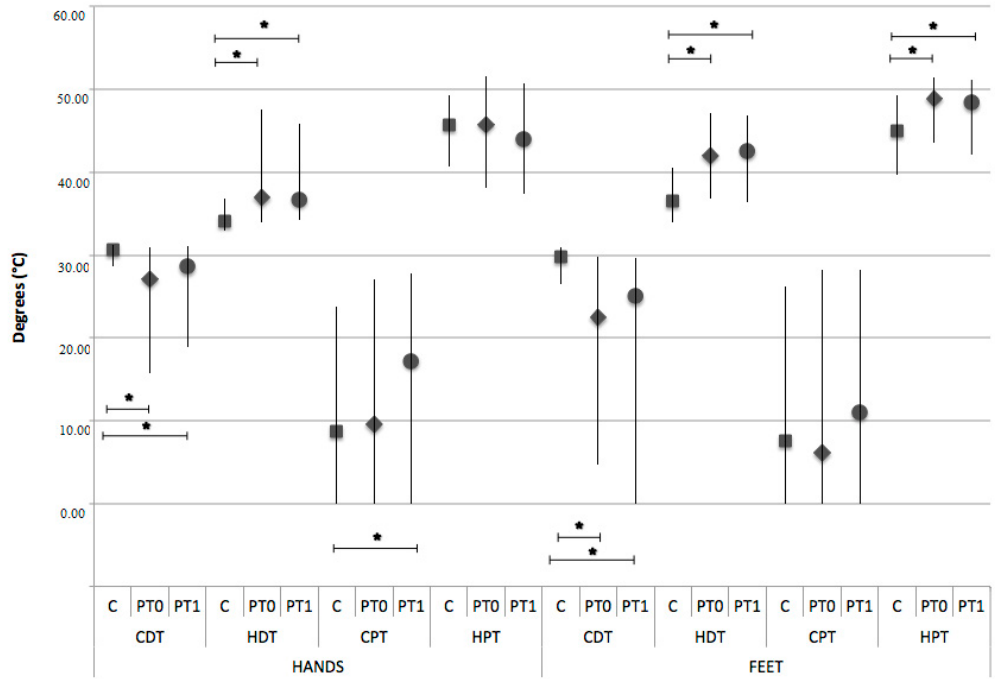
Figure 3. Quantitative Sensory Testing median values of cold and warm perception thresholds (CDT and HDT, respectively) and cold and heat pain thresholds (CPT and HPT, respectively) for hands and feet in control group (C) and patients before (PT0) and after (PT1) Sativex ® . CDT and HDT for both hands and feet and HPT for feet are significantly altered in patients compared to controls and do not change after therapy. CPT measured by hand stimulation significantly rises after therapy. *: statistically significant.